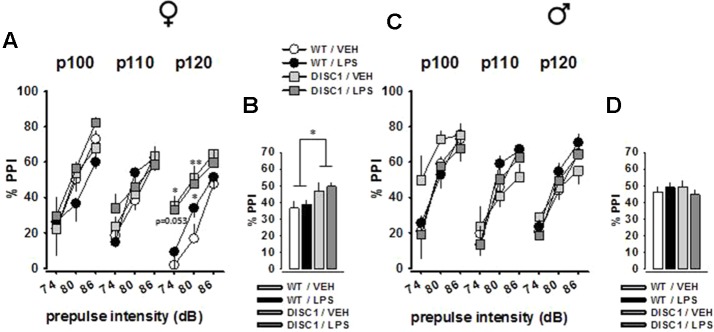
The effects of tgDISC1 with or without juvenile LPS administration on sensorimotor gating in adult female (left) and male rats (right). Prepulse inhibition of the acoustic startle stimulus is shown for each prepulse–pulse pair for female (A) and male rats (C). Prepulse inhibition of the acoustic startle stimulus is shown as the overall inhibition for female (B) and male rats (D). Background noise = 68 dB. n = 6–10 per group. Values are shown as mean ± SEM. *p < 0.05, **p < 0.01 compared to WT/VEH. WT, wild type; VEH, vehicle; LPS, lipopolysaccharide; PPI, prepulse inhibition; P100, pulse intensity = 100 dB; P110, pulse intensity = 110 dB; P120, pulse intensity = 120 dB.